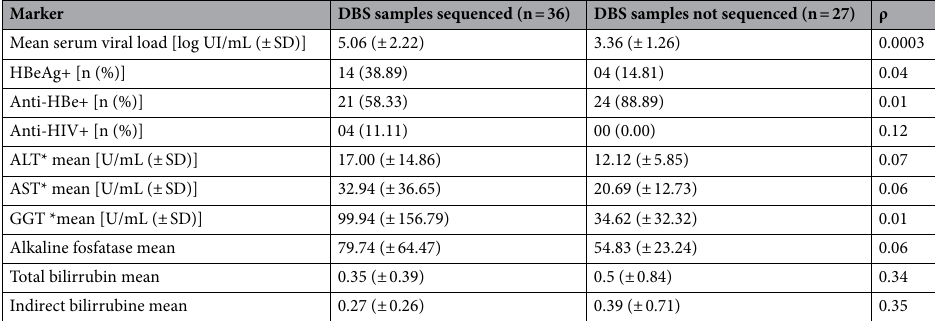
Table 6. HBV DNA sequencing in DBS samples correlated to HBV viral load, biochemical and serological markers. * ALT alanine-aminotransferase, AST aspartate-aminotransferase, GGT gama-glutamyltransferase (GGT).